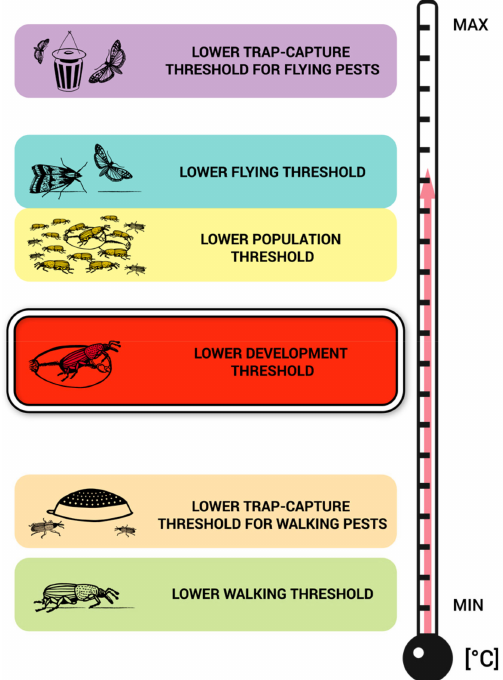
Figure 5. Schematic visualization of common relative positions of development and activity thresholds of stored product pests on an increasing temperature scale. Each species has di ff erent values and distances in the relative positions of these thresholds along the temperature scale. (Example of the concrete values currently available for Cryptolestes ferrugineus : LTCT-FP—23.3 ◦ C, LFT—22.5 ◦